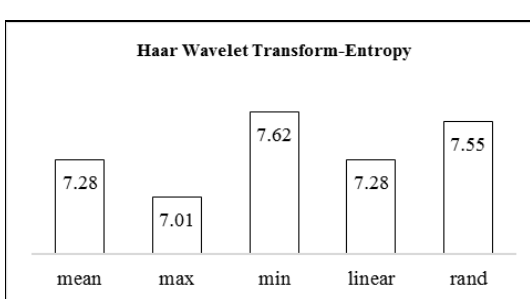
Figure 4. Entropy of different filters